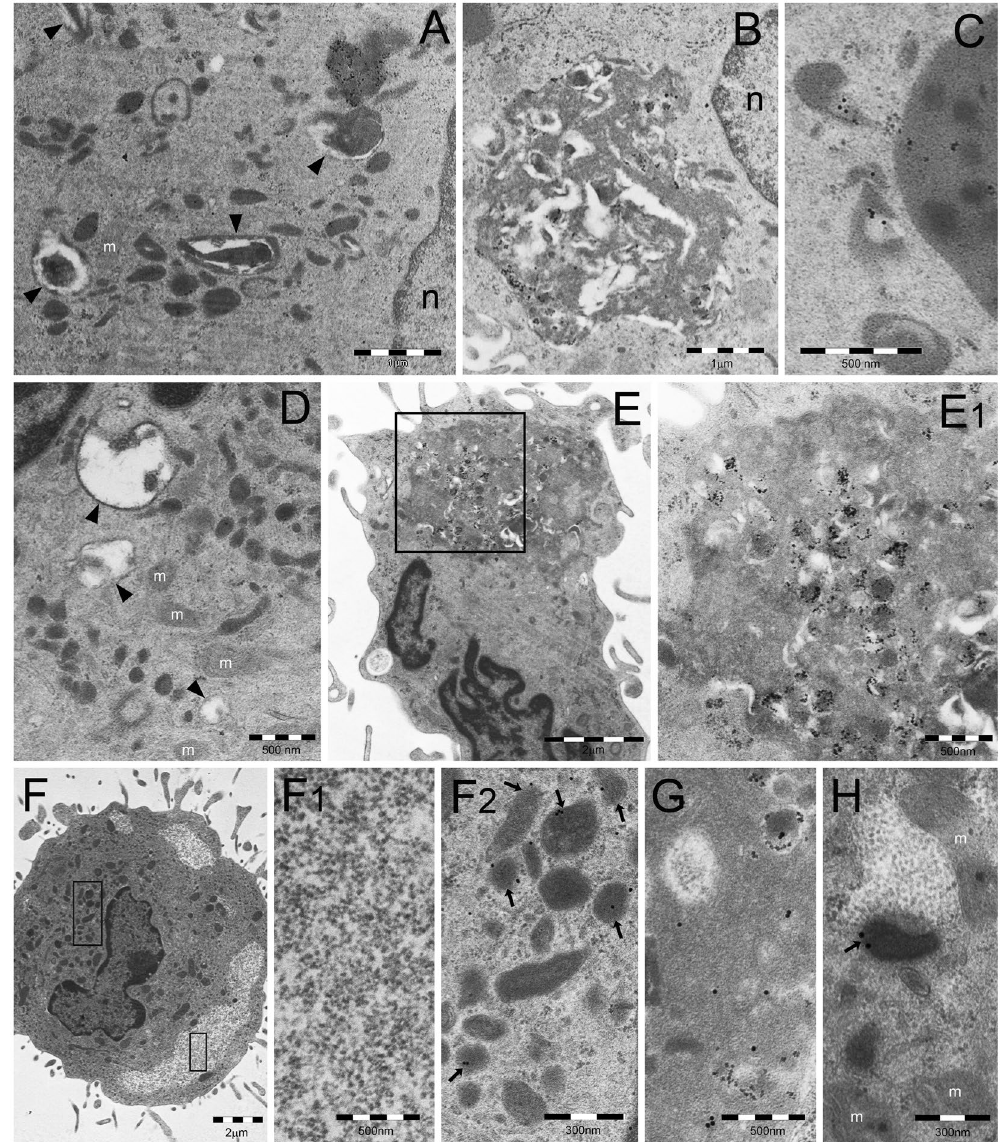
Figure 6. TEM analysis of DALIS development in GM/LPS-DC ( A – C ) or IFN α -DC ( D – E ). ( A ) Numerous endosomes of various shape and density and autophagic vesicles (arrowheads) are scattered in the cytoplasm of a DC incubated with GM-CSF for 5 days. ( B ) In cells first incubated with GM-CSF as in ( A ) and then treated with LPS, DALIS appear formed by a collection of vesicles with interposition of amorphous material and dense bodies. DALIS likely result from aggregation of autophagic vesicles and endosomes, as suggested in ( C ) by the LC3-reactive endosomes contacting a DALIS (on the right). ( D ) Abundant endosomal structures and few autophagic vesicles (arrowheads) are also found in the cytoplasm of a DC cell treated for 3 days with GM-CSF plus IFN α . ( E ) A large DALIS in the cytoplasm of another cell, treated as in ( D ), which is enlarged in (E1) to show vesicles and dense bodies embedded in an amorphous component. ( F ) An LPS treated IL4-DC showing PaCS (enlarged in F1) and aggregated endosomes (enlarged in F2). PaCS are negative for K63-linked polyubiquitin chains antibody (F1) while some endosomes (arrowheads) (F2) as well as a DALIS ( G , from an adjacent cell) show a clear reactivity. ( H ) The enlarged cytoplasm of another cell treated as in ( F ) and ( G ) shows p62 reactivity of an endosome (arrow) and lack of reactivity of an adjacent PaCs. m,